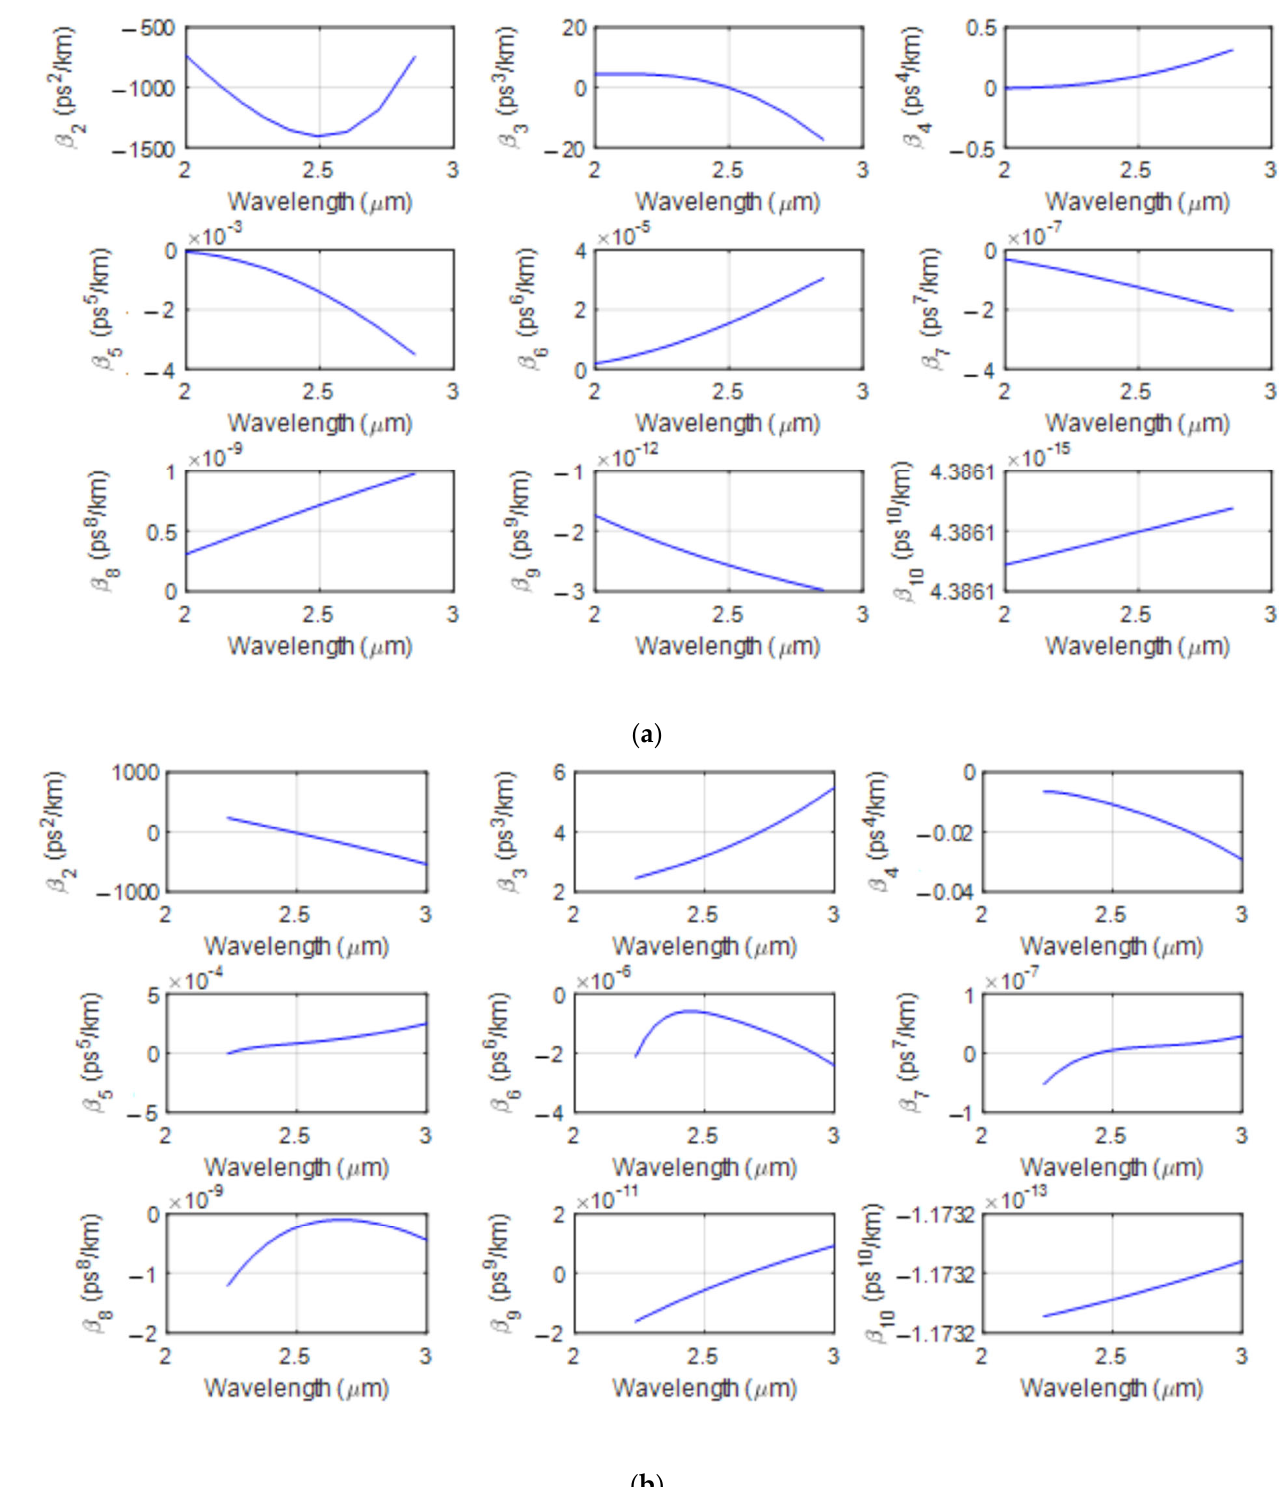
Figure 2. Higher ‐ order dispersions of ( a ) silicon PCF for 𝛬 (cid:3404) 0.75 μ m , 𝑑 𝛬(cid:3415) (cid:3404) 0.8 and ( b ) C ‐ PCF Figure 2. Higher-order dispersions of ( a ) silicon PCF for Λ = 0.75 µ m, d / Λ = 0.8 and ( b ) C-PCF for 𝛬 (cid:3404) 2.5 μ m , 𝑑 𝛬(cid:3415) (cid:3404) 0.8 . for Λ = 2.5 µ m, d / Λ = Table 1. The higher order dispersions coefficients of our proposed PCFs.